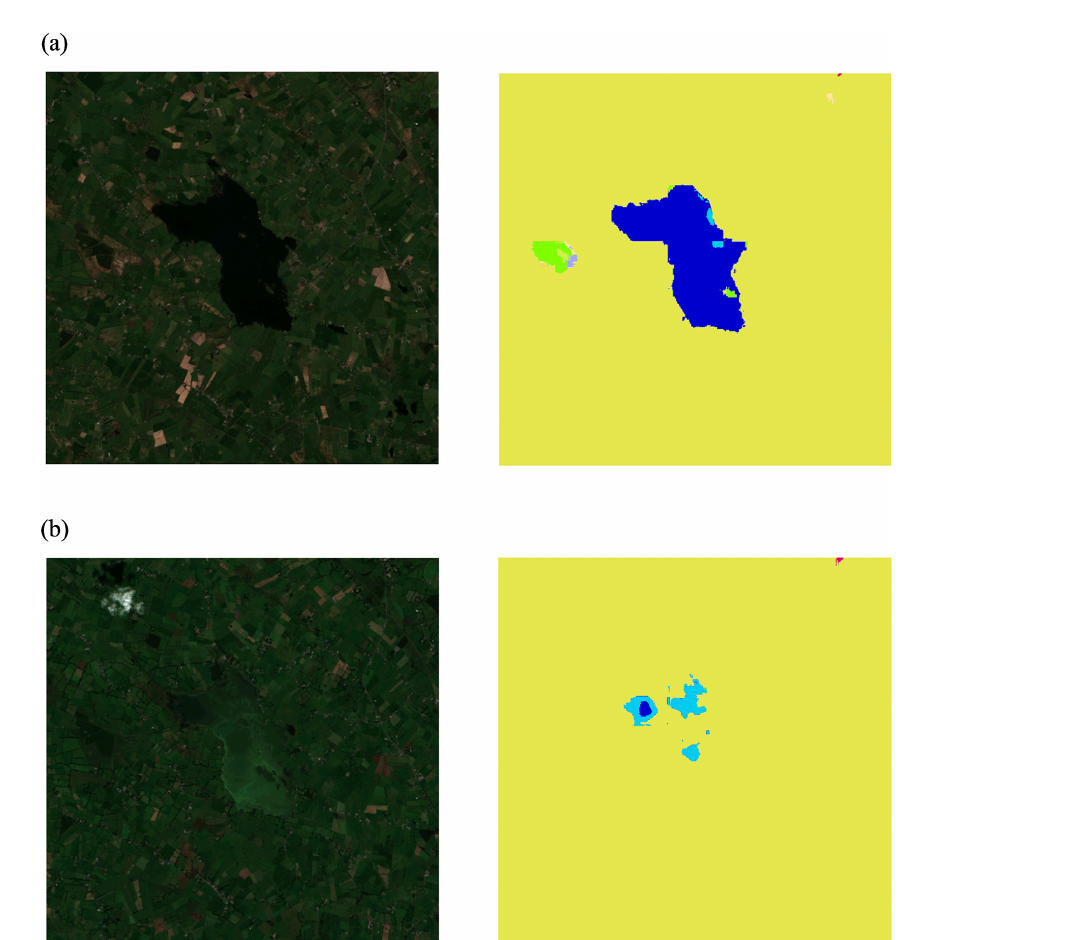
Figure D1. Lough Funshinagh, a Turlough (seasonal lake) in the West of Ireland in (a) April 2020 and (b) August 2020, obtained from Sentinel-2 satellite images, with the corresponding secondary UW map for both. The satellite images were produced from ESA remote sensing